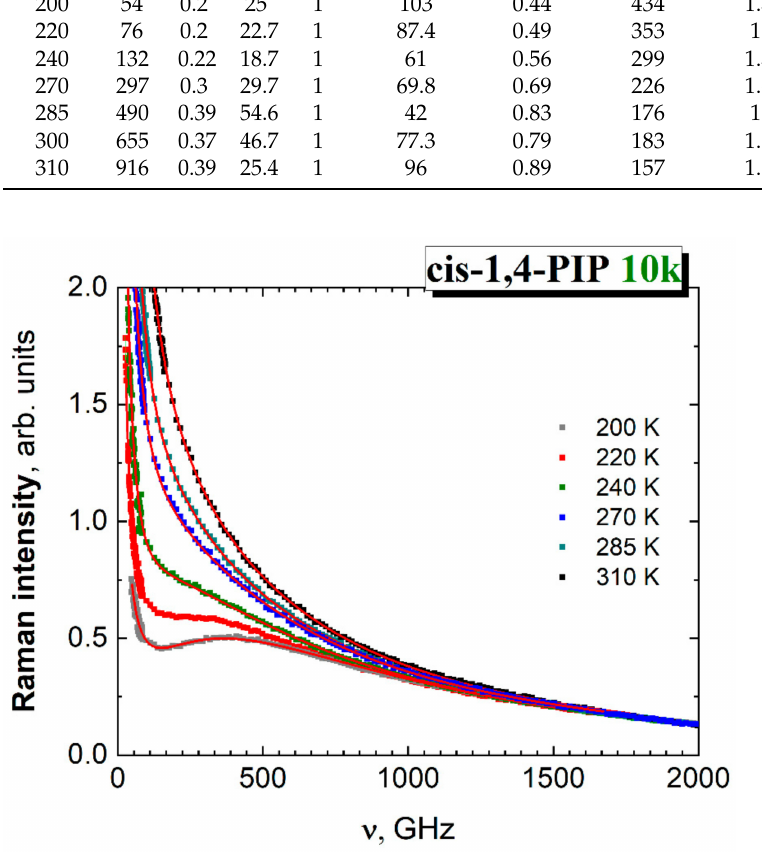
Figure 8. Raman spectra in spectral density representation from 200 K to 310 K. Fits using the additive model Equation (6) with parameters from Table 2 are included by red